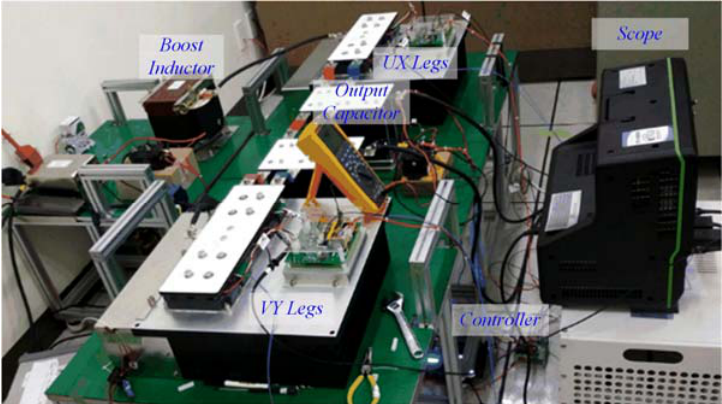
Figure 12. Prototype circuit of single ‐ phase PWM converter.